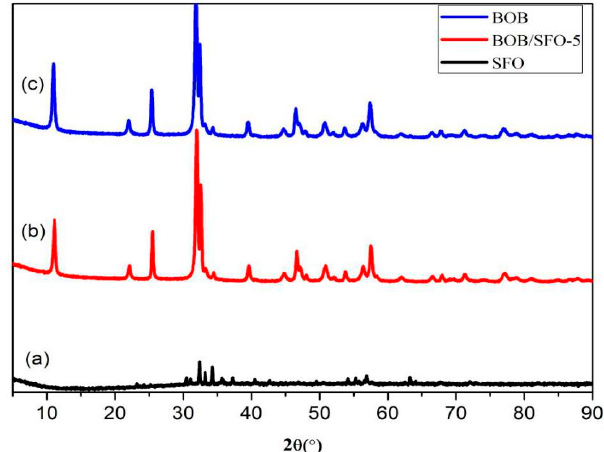
Figure 1. X-ray diffraction (XRD) patterns of pure ( a ) SrFe 12 O 19 (SFO), ( b ) BiOBr (BOB), and ( c ) BiOBr / SrFe 12 O 19 (5 wt %) (BOB / SFO-5).